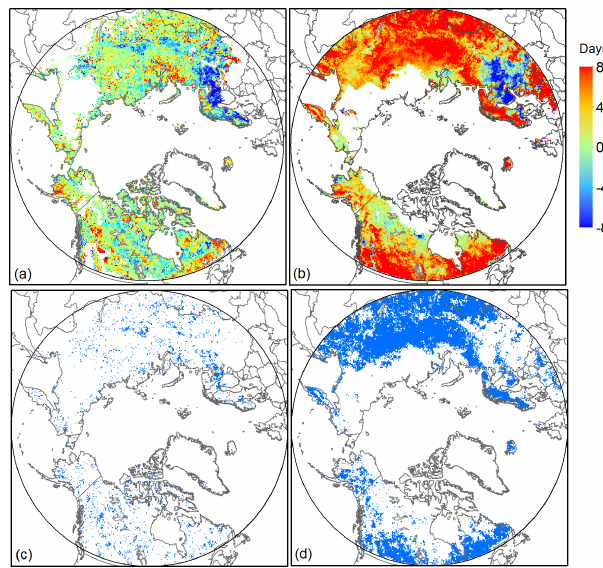
Figure 9. Mann-Kendall trends (days / 26 years) over the period 1988–2013 in the number of winter melt days from (a) PMW; (b) PMW-fixed; (c) and (d) show grid cells with trends statistically significant at the 90% level in (a) and (b) respectively.